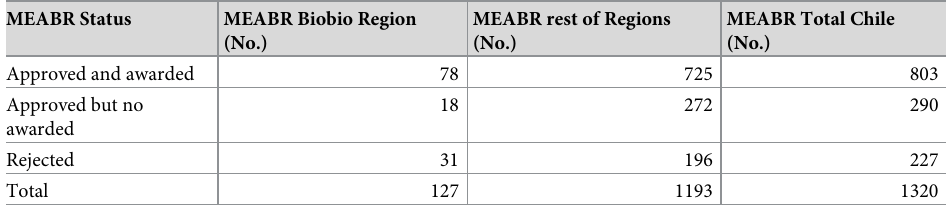
Table 1. Status of the Management and Exploitation Areas of Benthic Resources (MEABR).